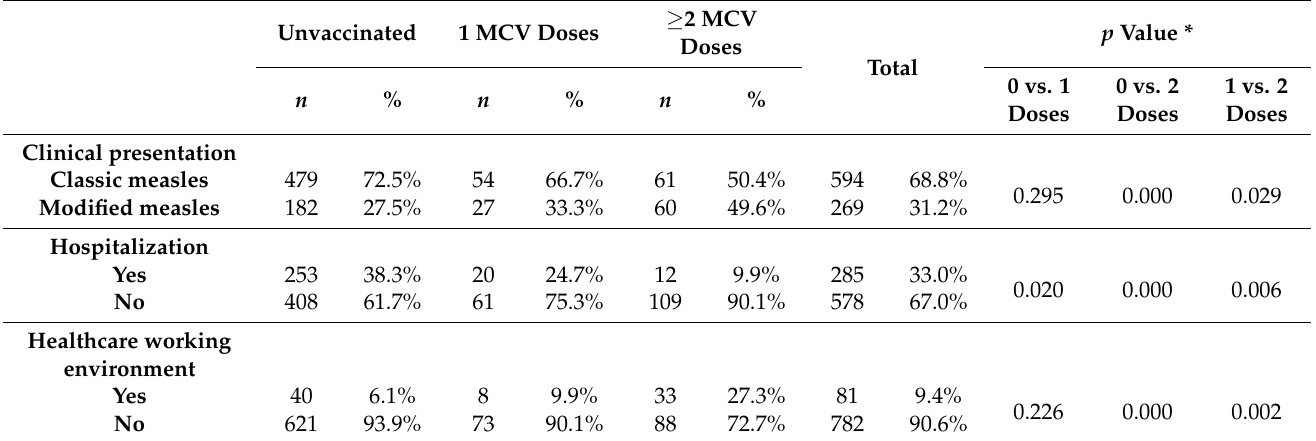
Table 3. Global characteristics for measles cases. Spain,